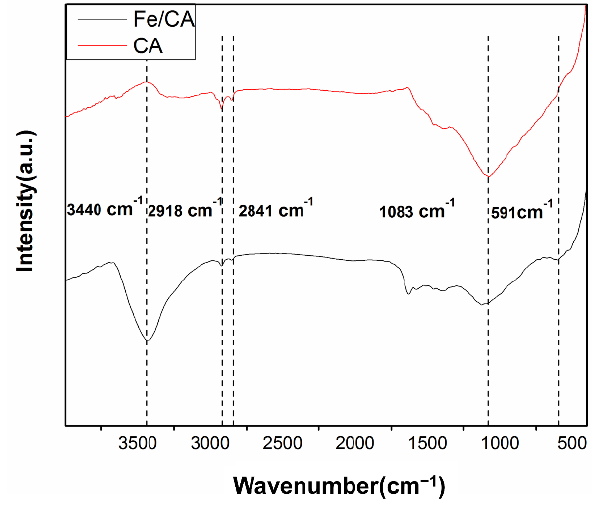
Figure 3. FTIR spectra of CA and Fe/CA.